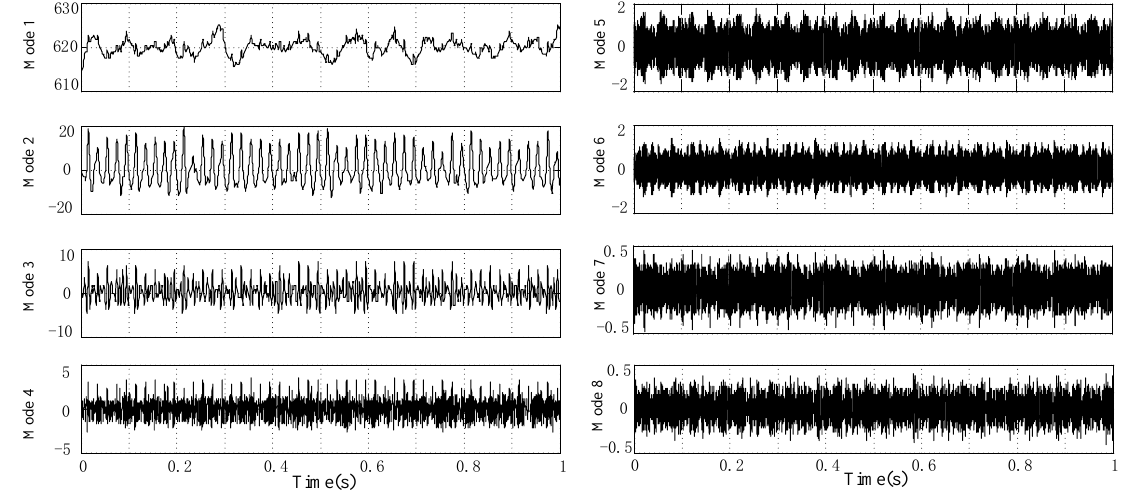
Figure 26. The decomposed modes of VMD-HT algorithm. (mode1: DC value 620 V, mode 2: 50 Hz, mode 3:100 Hz, mode 4: 150 Hz, mode 5:200 Hz, mode 6:250 Hz, mode 7: 300 Hz, mode 8: 350 Hz).